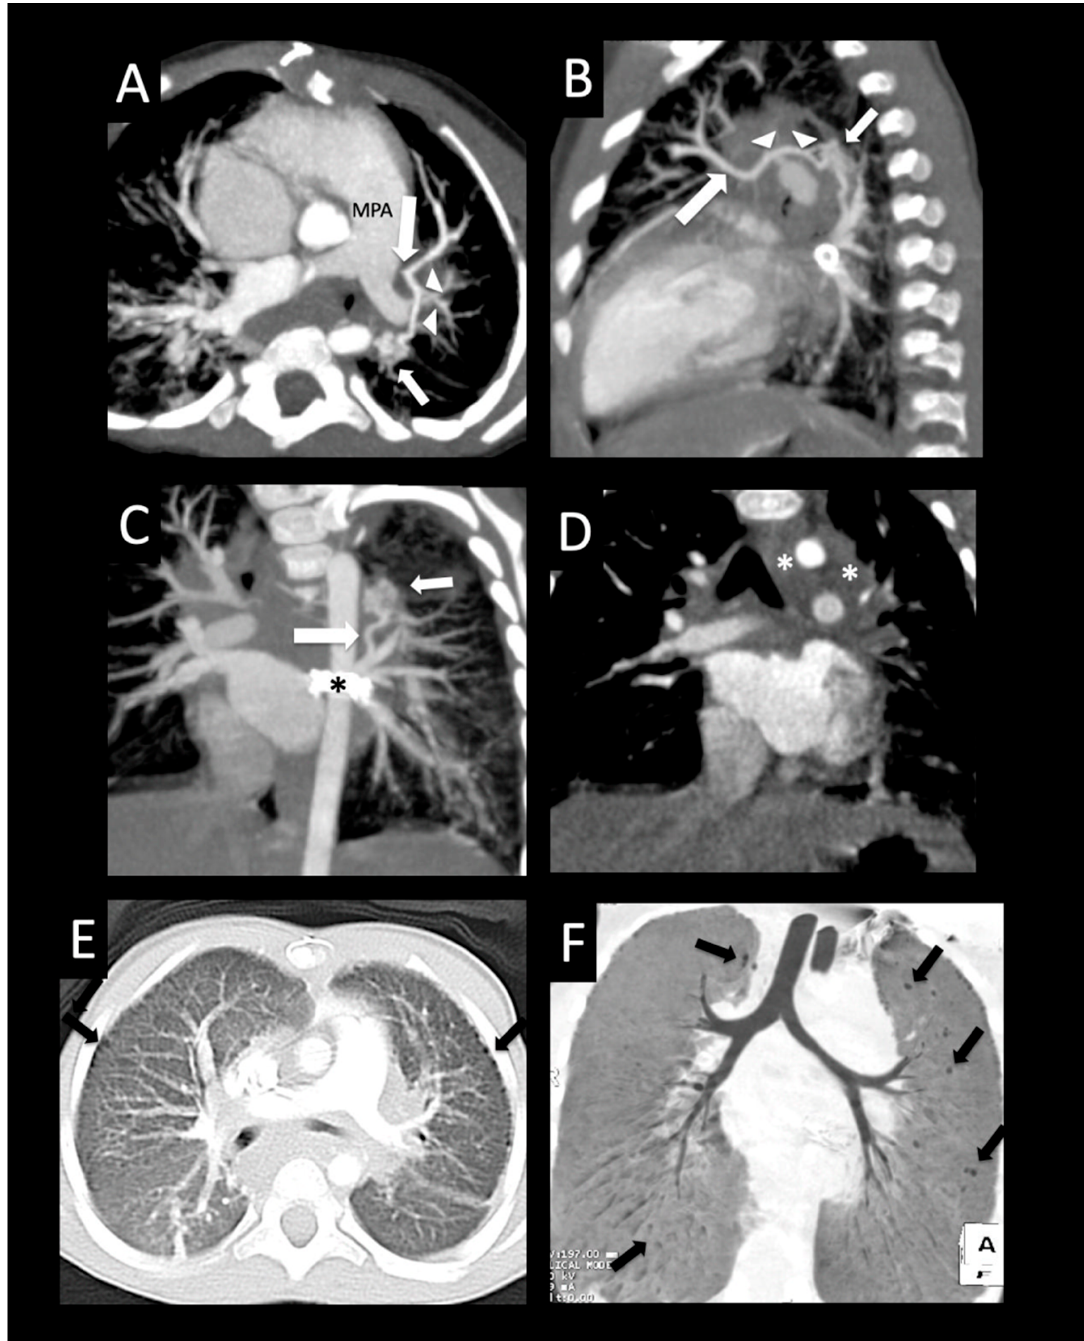
Figure 8. Ex-premature infant with pulmonary vein stenosis. Former 26-week premature infant with chronic lung disease, who underwent sutureless repair of PVS followed by left lower pulmonary vein stenting. Axial ( A ), sagittal ( B ), and coronal ( C ) images from a CTA performed 1 year later show left upper pulmonary vein atresia (large arrow ( A , B )) in proximity to the dilated main pulmonary artery (MPA), with an enhancing interlobar collateral vessel coursing around the left pulmonary artery (arrowheads ( A , B )), which connects to a cluster of vessels (small arrow ( A – C )). Another tortuous collateral (large arrow ( C )) connects the cluster of vessels to the stented left lower pulmonary vein (* C ). Coronal image ( D ) shows perihilar and mediastinal induration (*). Axial lung image ( E ) shows diffuse interlobular septal thickening, and a coronal minimum-intensity projection ( F ) image shows peripheral and intralobar tiny cysts (arrows ( E , F )). The cysts do not correspond to lung segments most affected by PVS, and may be related to chronic lung disease.